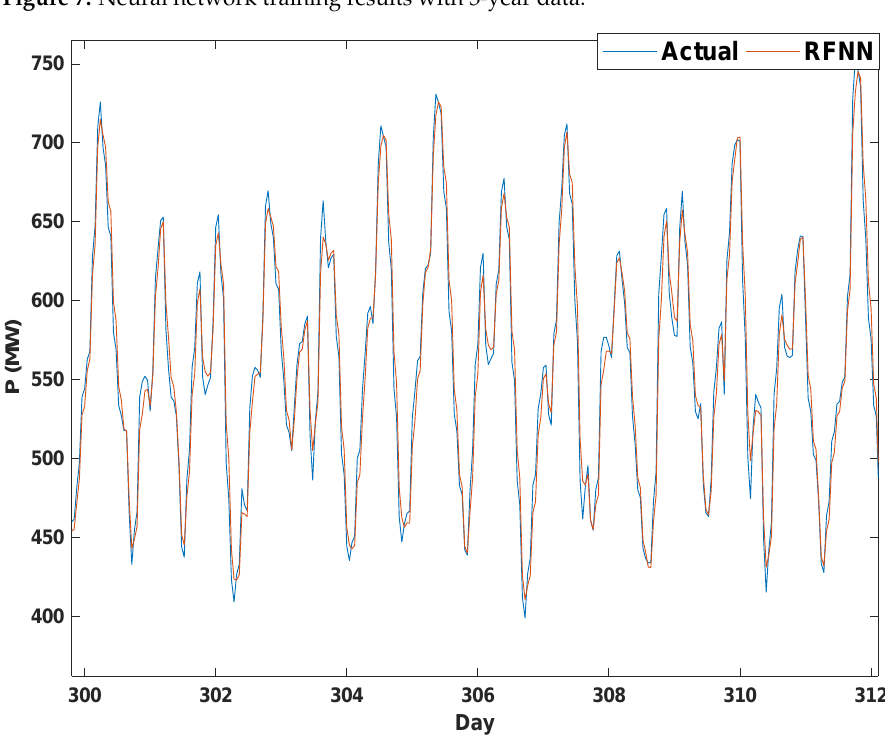
Figure 7. Neural network training results with 3-year data.